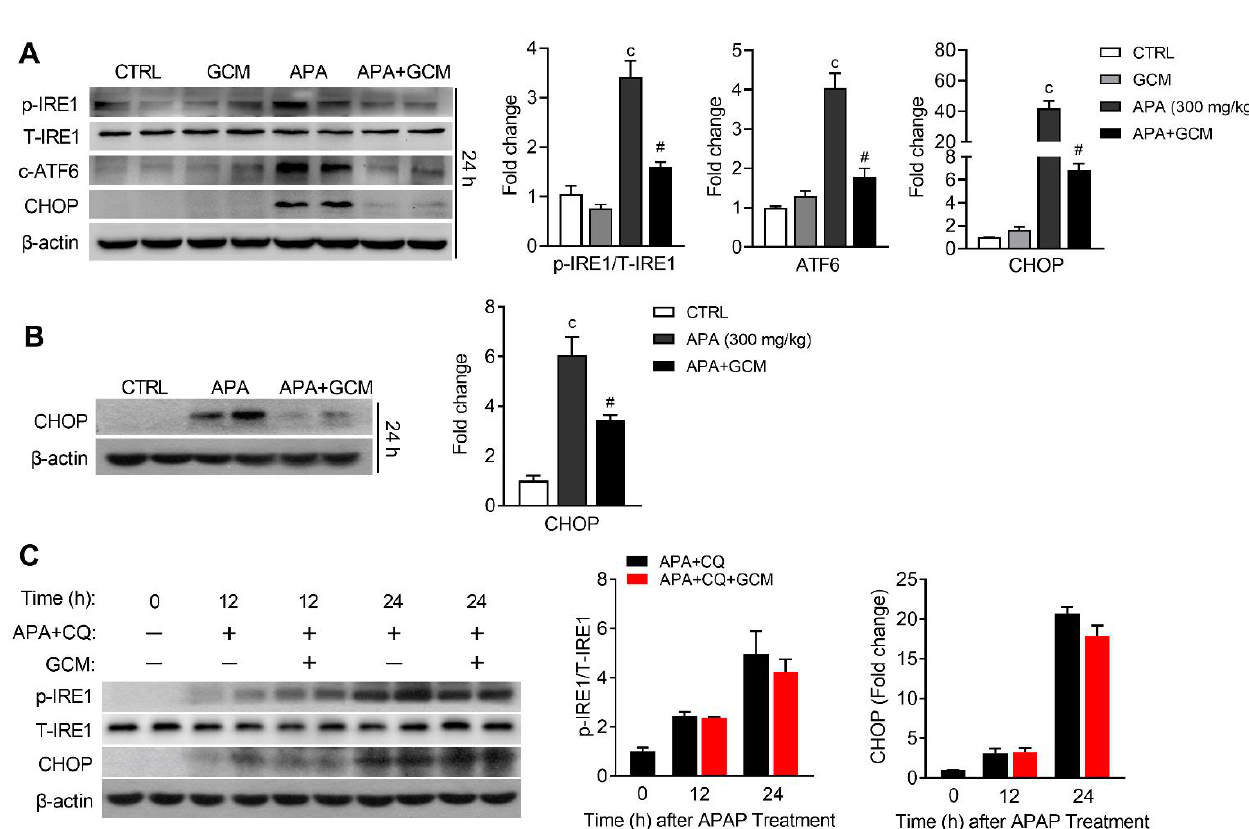
Figure 5. GCM suppresses ER stress via enhancing ER-phagy. ( A , B ) Mice were treated with 300 mg/kg of APA, followed by 100 mg/kg of GCM 6 and 18 h after APA. Livers were harvested at 24 h for analysis. ( A ) Immunoblot analysis for p-IRE1, toral IRE1, the cleavage of ATF6 and CHOP (left panel) and the corresponding densitometry normalized to the corresponding total protein or β-actin (right panel). ( B ) Immunoblot analysis for CHOP at 24 h after APA in Nrf2 knockout mice (left panel) and the corresponding densitometry normalized to β-actin (right panel). ( C ) Mice were treated with APA, followed by CQ and GCM treatment. Immunoblot analysis of a whole-liver homogenate for p-IRE1 CHOP at 12 and 24 h after the APA overdose (left panel) and the corresponding densitometry normalized to the corresponding total protein or β -actin (right panel). Data are presented as the mean ± SEM. c: p < 0.001 compared with the vehicle control. # p < 0.05 compared with the corresponding APA-treated